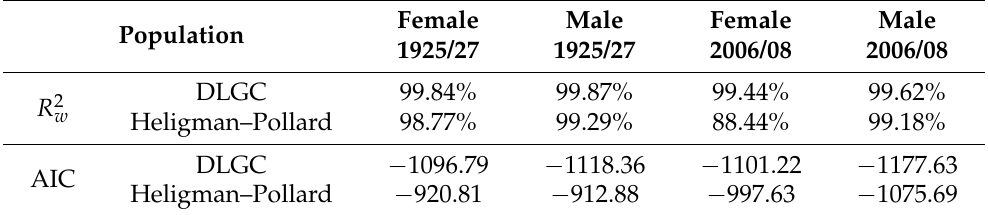
Table 2. Comparing the fitting accuracy of DLGC and the Heligman–Pollard model for South Africa.